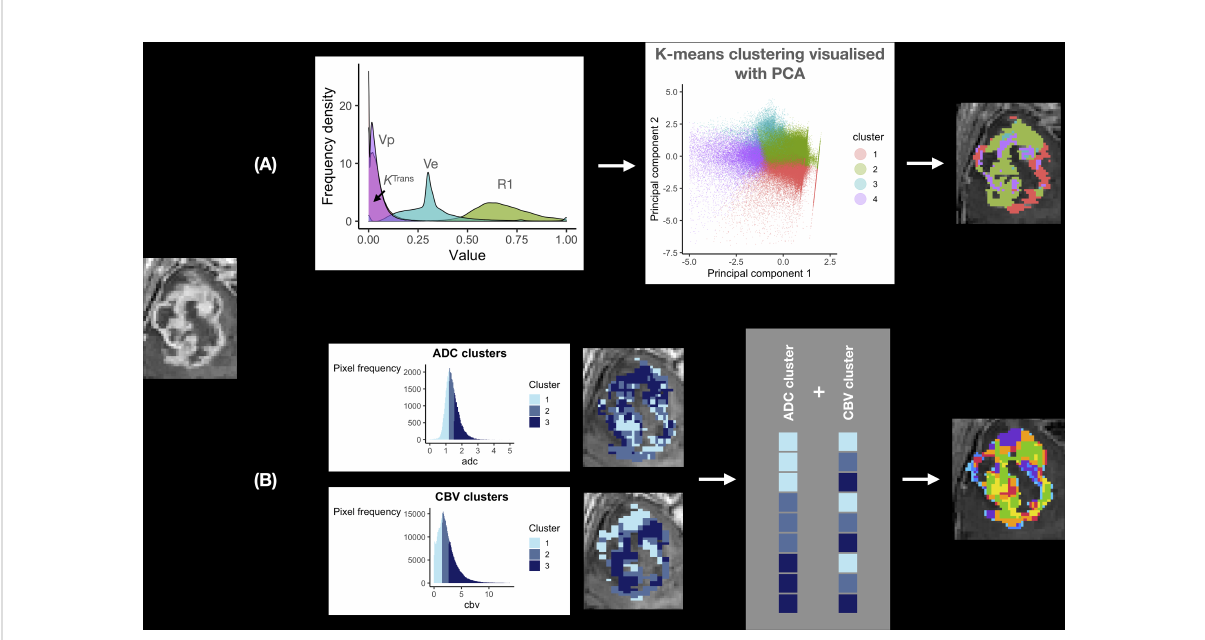
FIGURE 2 Habitat imaging methods in glioblastoma. This fi gure provides an overview of the two main approaches to deriving imaging habitats utilising local preoperative data from 12 patients with glioblastoma undergoing surgery. (A) one step approach: a multi-dimensional dataset can be produced utilising multiple imaging biomarkers from the same MRI acquisition (to avoid interpolation/registration errors), in this case Dynamic Contrast Enhanced (DCE) MRI. Data from R1 N – de fi ned in Table 1 and three DCE-MRI imaging biomarkers ( K trans , v p and v e ) were input into a machine learning K-means clustering algorithm to produce four distinct imaging habitats, that were distinct on Principal Component Analysis (PCA; right). A disadvantage of this approach is its ‘ black-box ’ nature, such that it is not straightforward to de fi ne each habitat for prospective validation. (B) Two step approach: this step fi rst requires clustering of individual imaging biomarkers, in this case ADC and rCBV (left). Each pixel is then assigned to a habitat based on its ADC/rCBV cluster, with multiple cluster combinations de fi ning each habitat (grey box). The advantage of this approach is that imaging biomarkers from different MRI acquisitions (e.g. diffusion and perfusion MRI) can be utilised. It is also easier to de fi ne each habitat as the de fi nition of each is derived from its individual ADC/rCBV cluster composition. This approach therefore allows for prospective validation with pre-de fi ned cluster